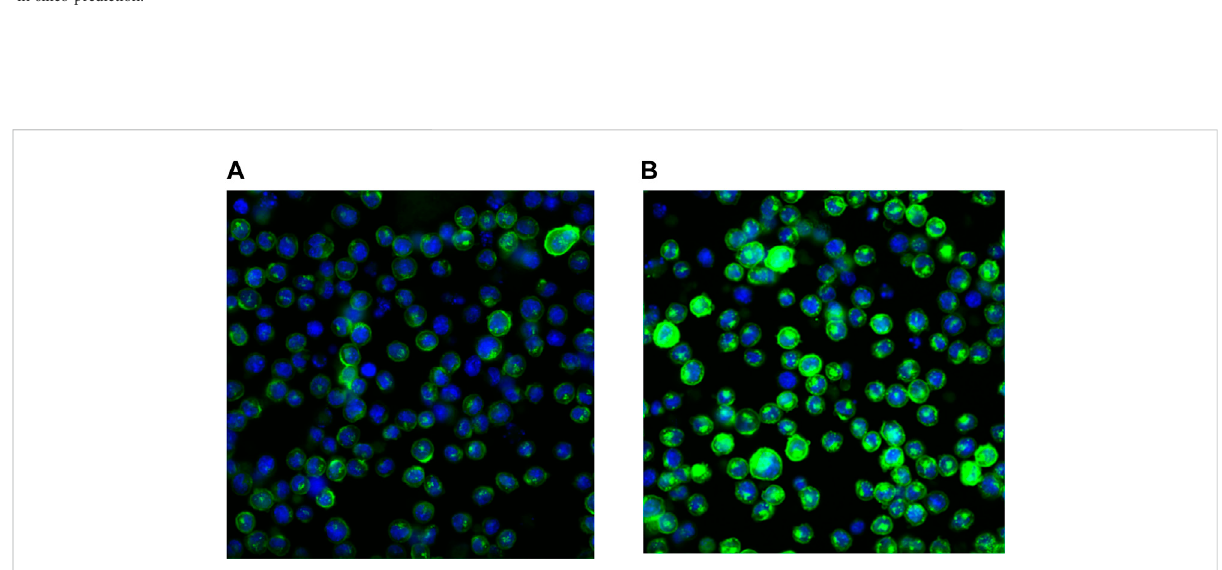
FIGURE 2 BindingofSAR441566tohumanTNFoncells:ThebindingofSAR441566tohumanTNFonthecellsurfaceandintracellularly.Anin-houseNSO